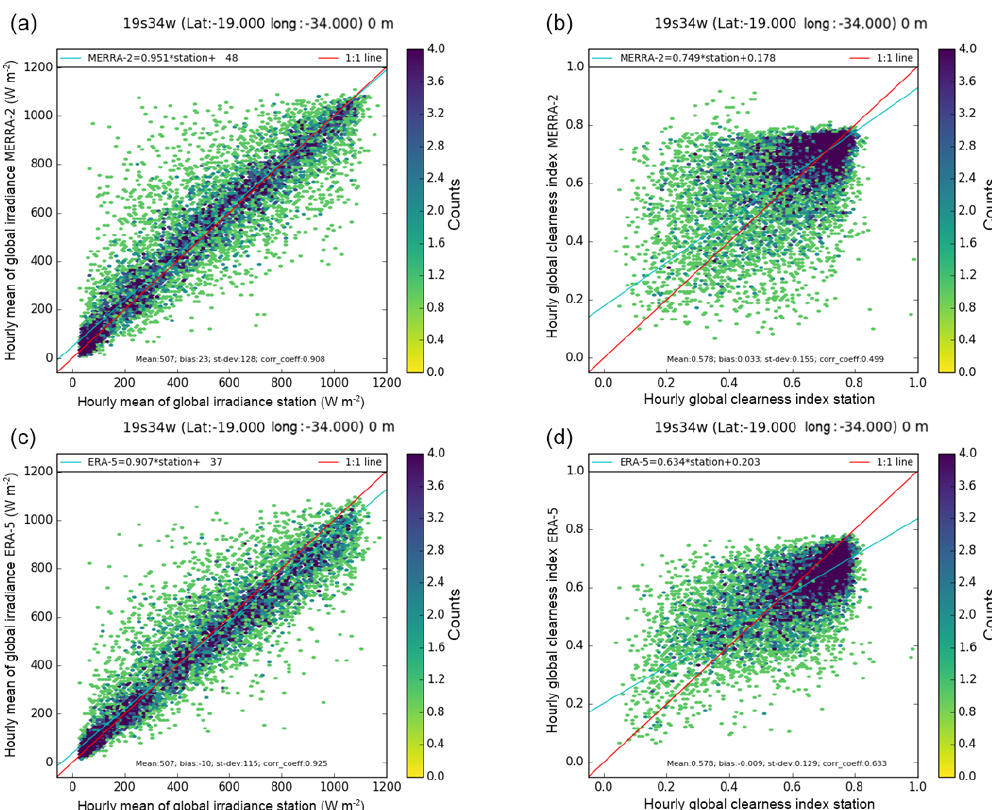
Figure D4. The 2-D histograms of PIRATA measurements (horizontal axis) and data sets (vertical axis) at 19 ◦ S, 34 ◦ W for E and KT. MERRA-2: (a) and (b) ; ERA5: (c) and (d) . Ideally, the dots should lie along the red line (1:1 line). The blue line is the affine function fitted over the points and should ideally overlay the red line.